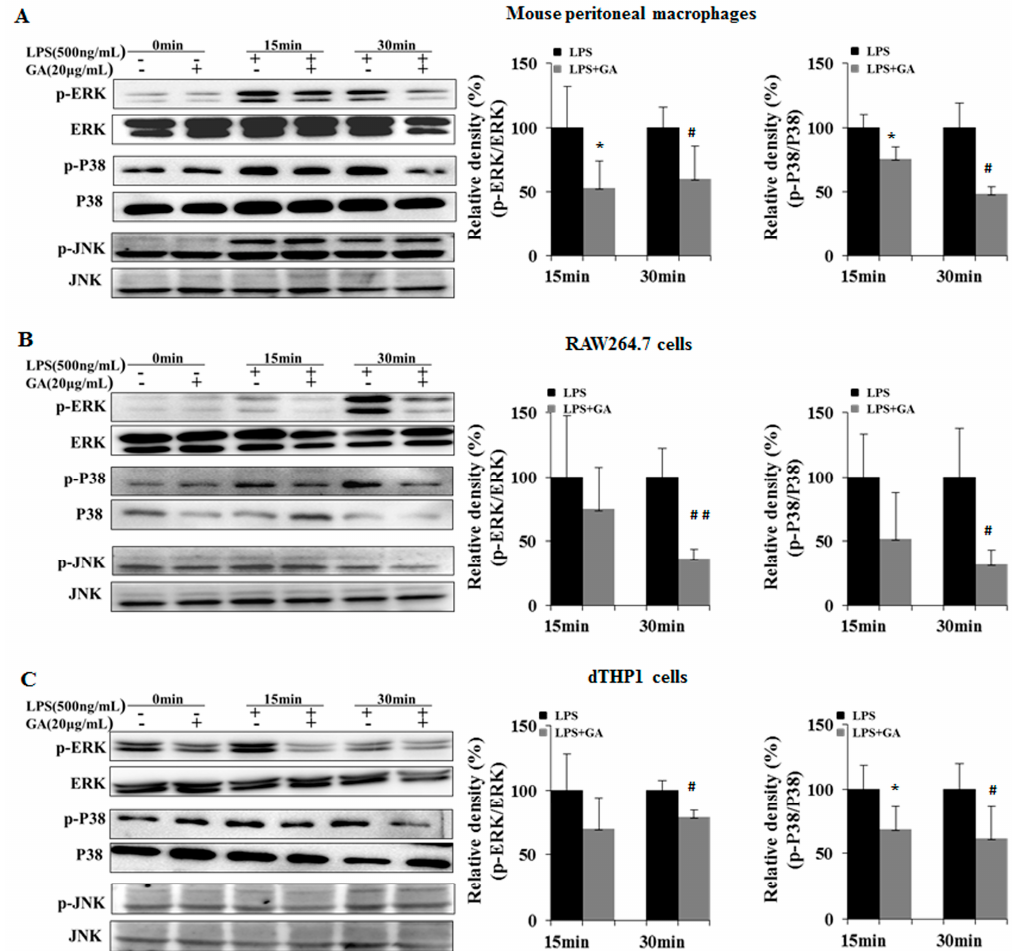
Figure 4. GA suppresses activation of MAPKs. ( A ) Mouse peritoneal macrophages; ( B ) RAW264.7 cells; and ( C ) dTHP-1 cells were pre-treated with 20 μ g/mL GA for 1 h and then stimulated with LPS (500 ng/mL) for 0, 15, and 30 min. Total cellular proteins were obtained from the cells and analyzed for phosphorylation of ERK, JNK, and p38 by Western blotting. The histograms show relative density ratios (fold changes) measured by Image J. Values are presented as means ± SD of three independent experiments. * p < 0.05 versus LPS group at 15 min; # p < 0.05, ## p < 0.01 versus LPS group at 30 min. p, phospho; ERK, extracellular signal-regulated kinase; JNK, c-Jun N-terminal kinase.